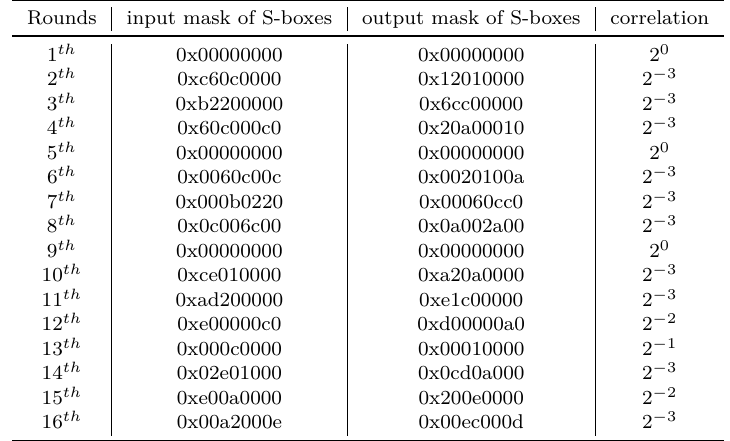
Table 17: The best linear characteristic with correlation 2 − 35 for 16-round